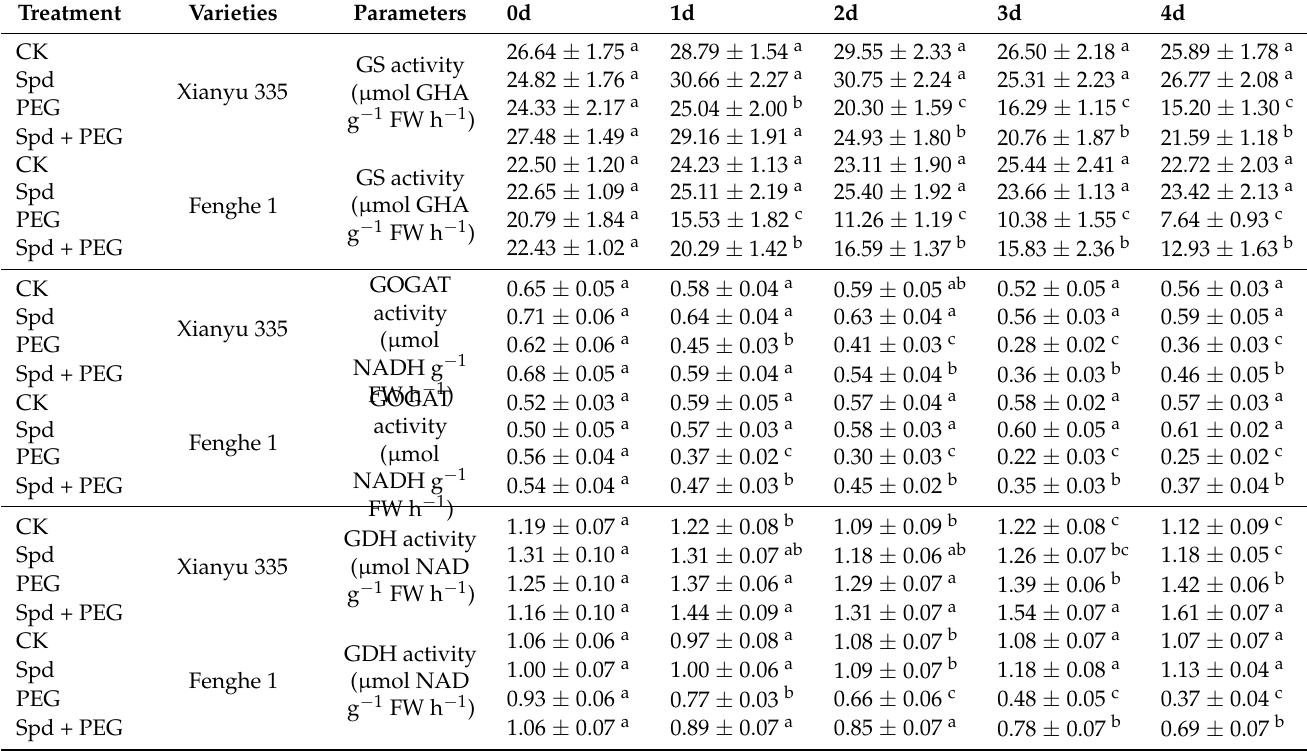
Table 4. Effects of exogenous Spd on activities of glutamine synthetase (GS), glutamate synthase (GOGAT) and glutamate dehydrogenase (GDH) in leaves of maize seedlings under drought